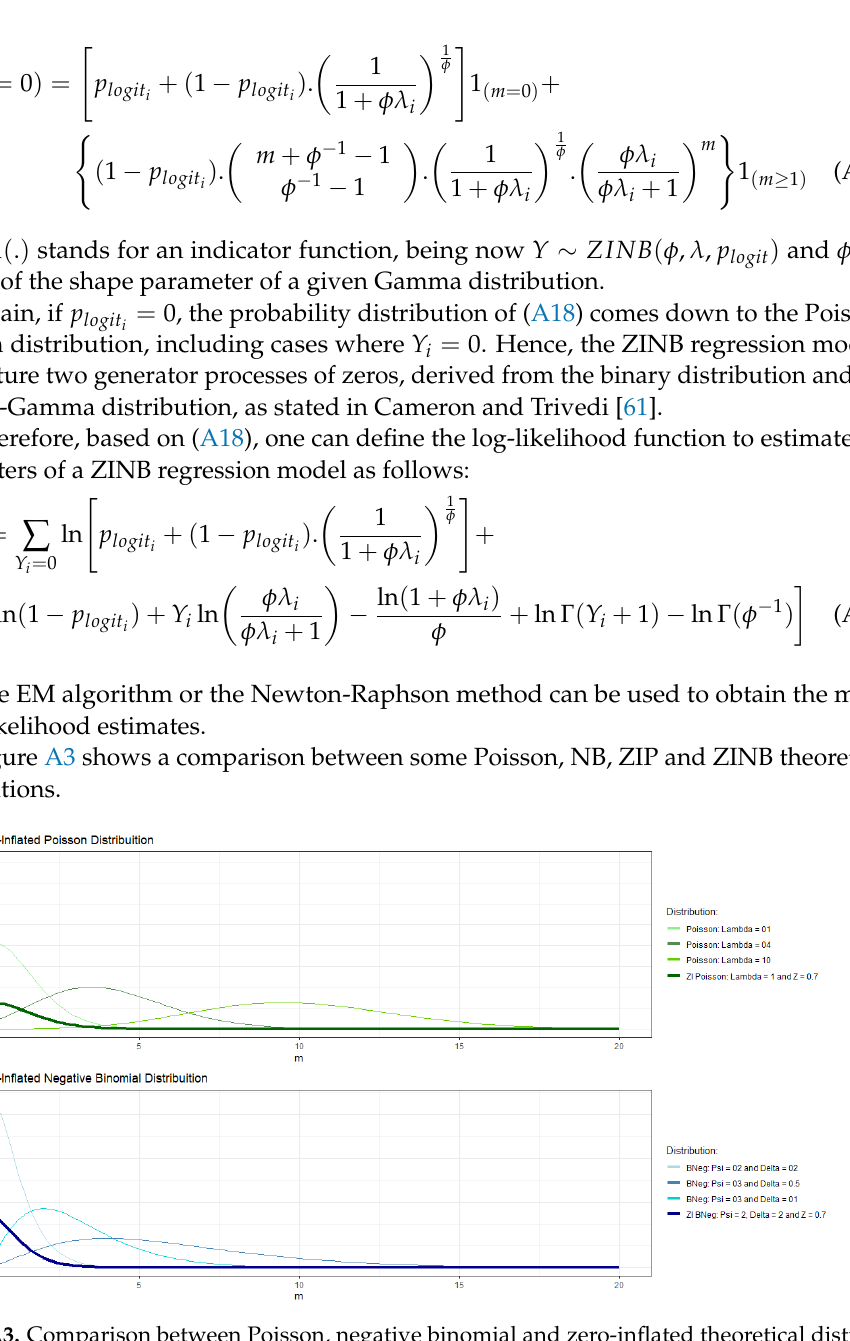
Figure A3. Comparison between Poisson, negative binomial and zero-inflated theoretical distribu-